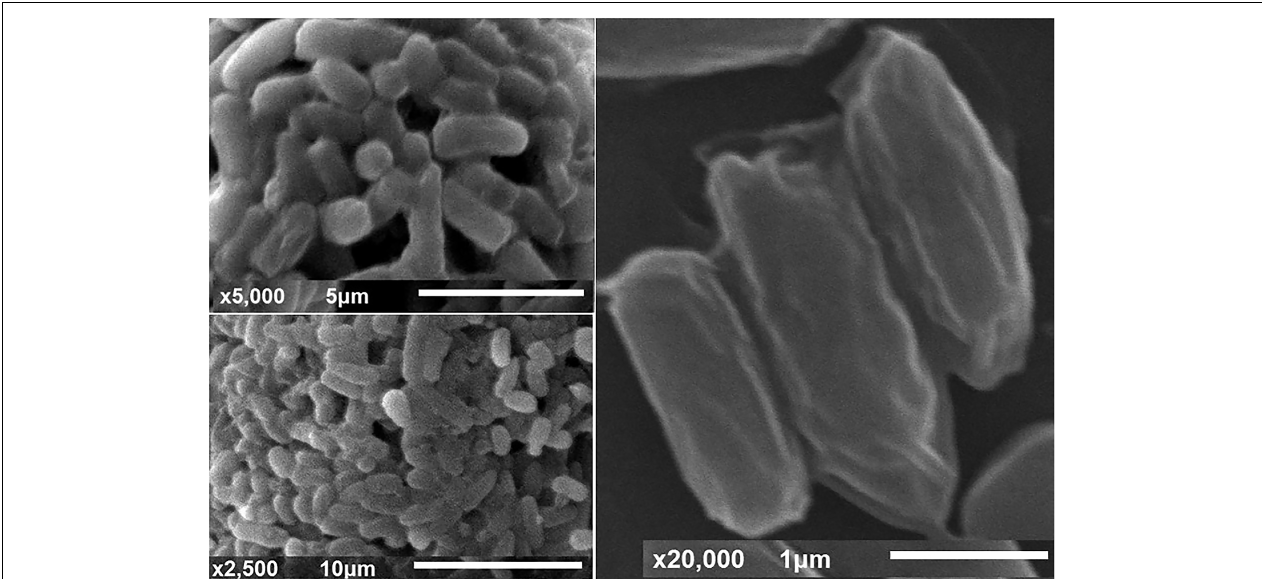
FIGURE 2 | SEM micrograph of Bacillus paramycoides at various magnification powers.